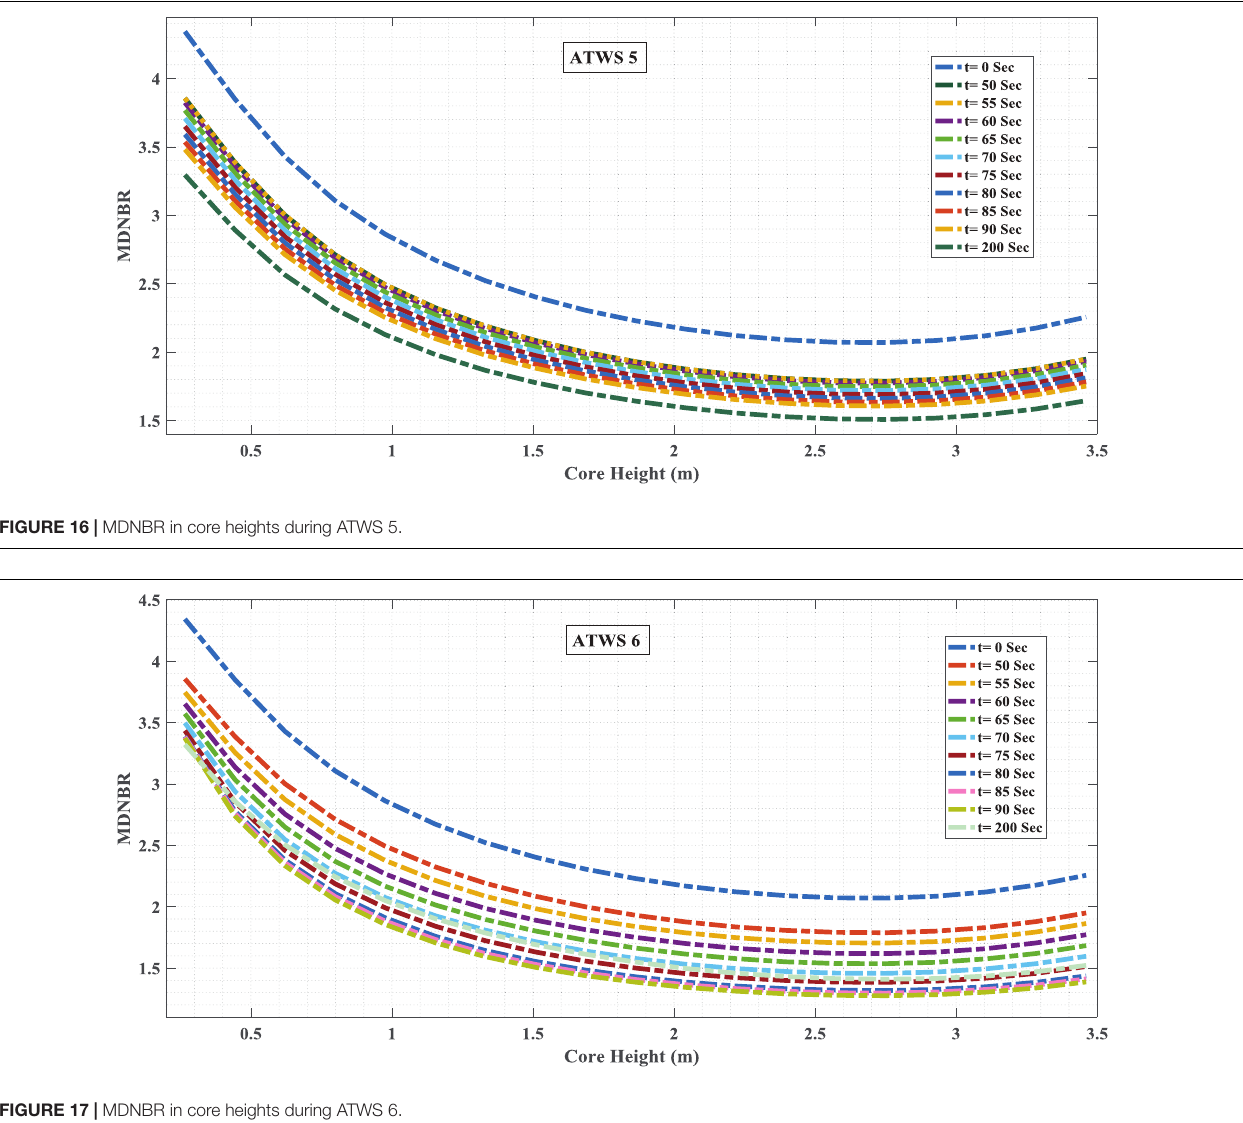
FIGURE 17 | MDNBR in core heights during ATWS